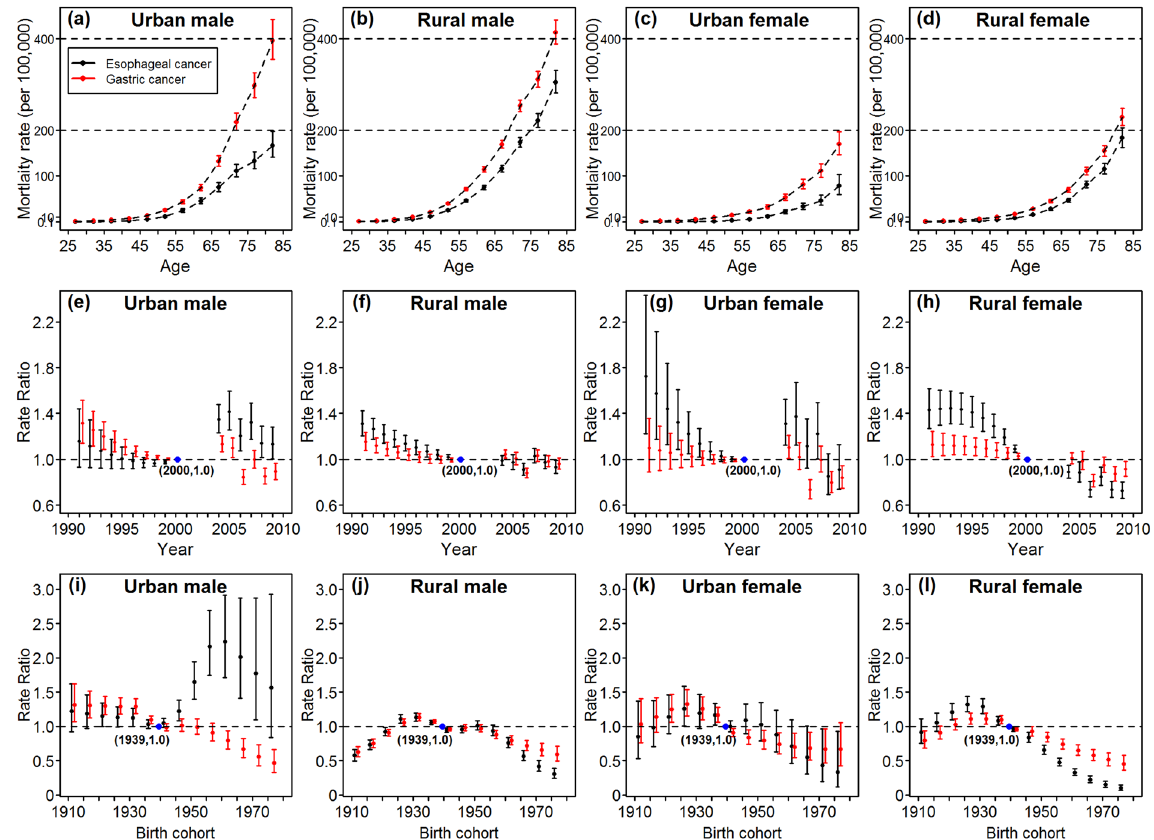
Figure 3. Age, period, and cohort effects on esophageal cancer and gastric cancer mortality, stratified by region and sex. ( a–d ) In the first row represent age-specific mortality rates in the reference period of 2000 after adjusting for period and cohort effects. ( e–h ) In the second row are the estimated period effects, and the blue dot is the reference period. ( i–l ) In the last row are the cohort effects, and the blue dot is the reference cohort.